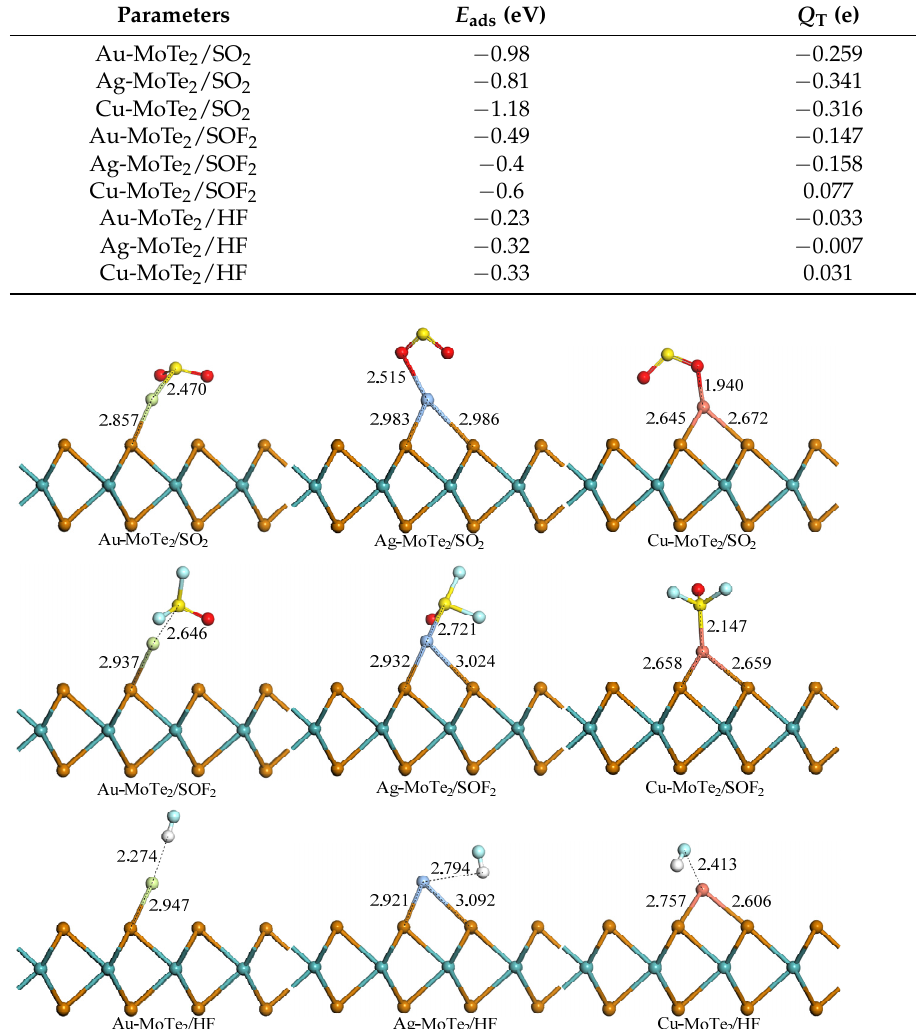
Figure 4. Adsorption systems of the gas molecule on TM-MoTe 2 monolayer. The unit is